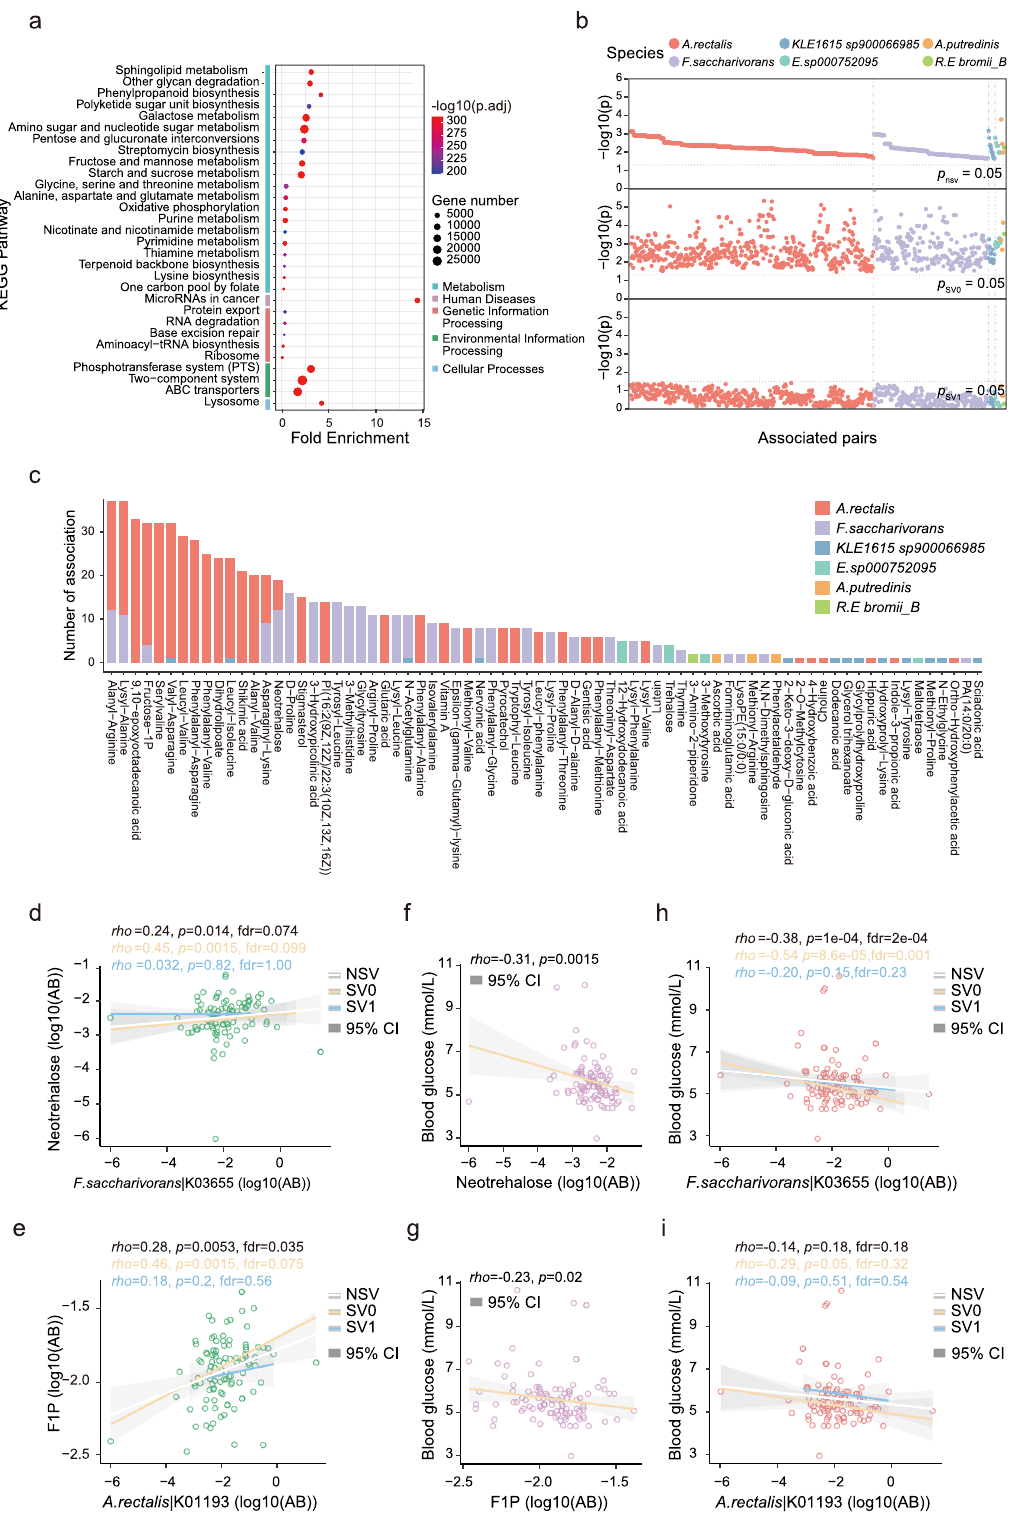
human gut microbiome. Indeed, we found that the inter-personal differences in our cross-sectional cohort were signi fi cantly higher than those within same individuals (in our time-series cohort), as measured by beta-distances based on prophage/CRISPR spacers (Jaccard distance calculated using prophage: Wilcoxon-test p < 2e-16; using CRISPR spacers: Wilcoxon-test p < 2e-16) (Supplementary Fig. 11). Further comparisons between the